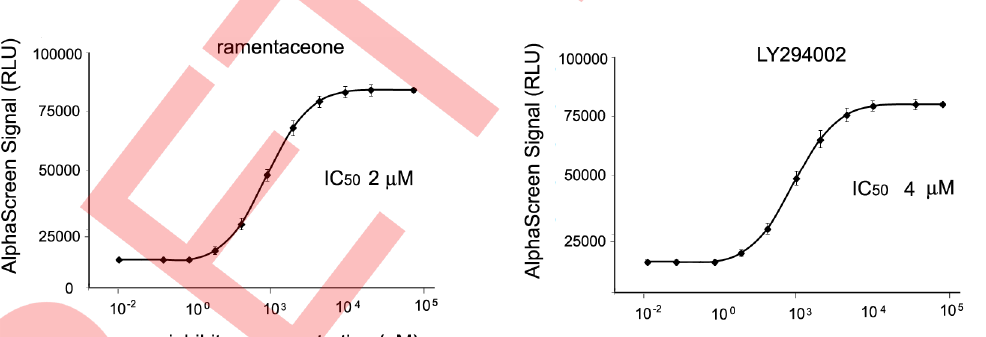
Fig 4. Inhibition of phosphoinositide-3-kinase (PI3-kinase) activity by ramentaceone in breast cancer cells. The AlphaScreen technology was used to determine enzyme activity. The AlphaScreen assay was performed with ramentaceone or LY294002, added at concentrations ranging from 100 μ M to 0.01 nM, 25 ng PI3-kinase, 5 μ M PIP 2 , 10 μ M ATP and with an incubation time of 1 h. Values represent mean ± SD of three independent